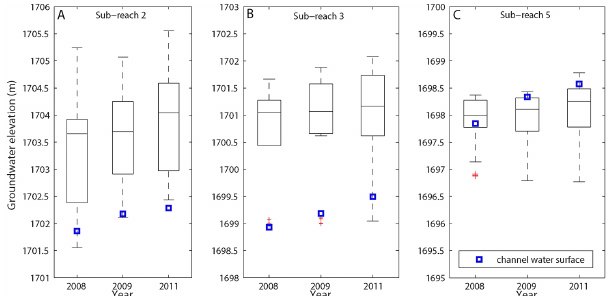
Figure 7. Groundwater elevations grouped by individual sub- reaches and shown with channel water surface elevations. The groundwater elevations were measured 4 times in 2008, 5 times in 2009, and 4 times in 2011. The water surface elevation in the chan- nel represents the average yearly value for each sub-reach. There is a gradual increase in groundwater elevation and channel water surface elevation in all sub-reaches over the years.